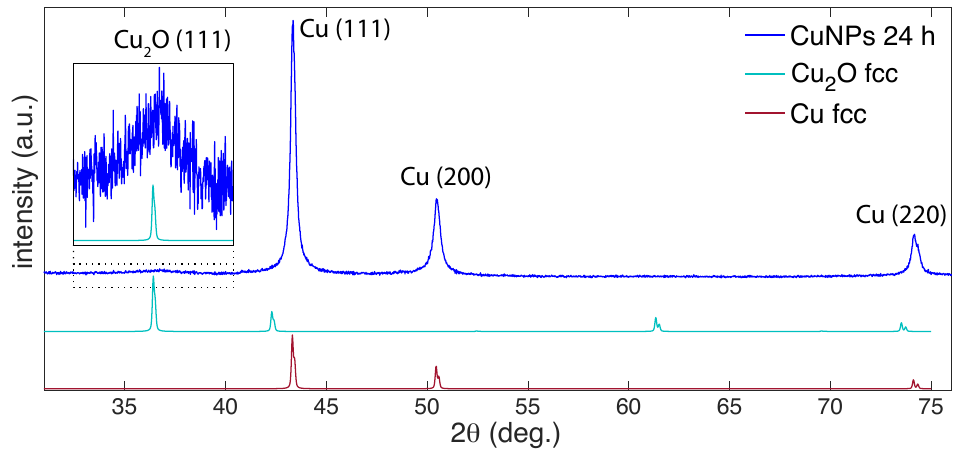
Figure 2. XRD spectrum of 24 h sample (blue), with references for Cu Inset magnifies a broad peak observed in the spectra for 24 h sample indexed to Cu